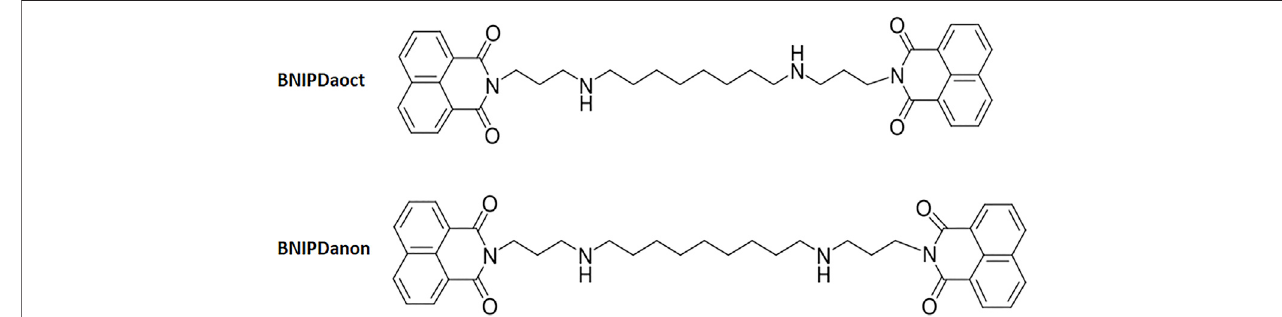
FIGURE 1 | Scheme of BNIPDaoct and